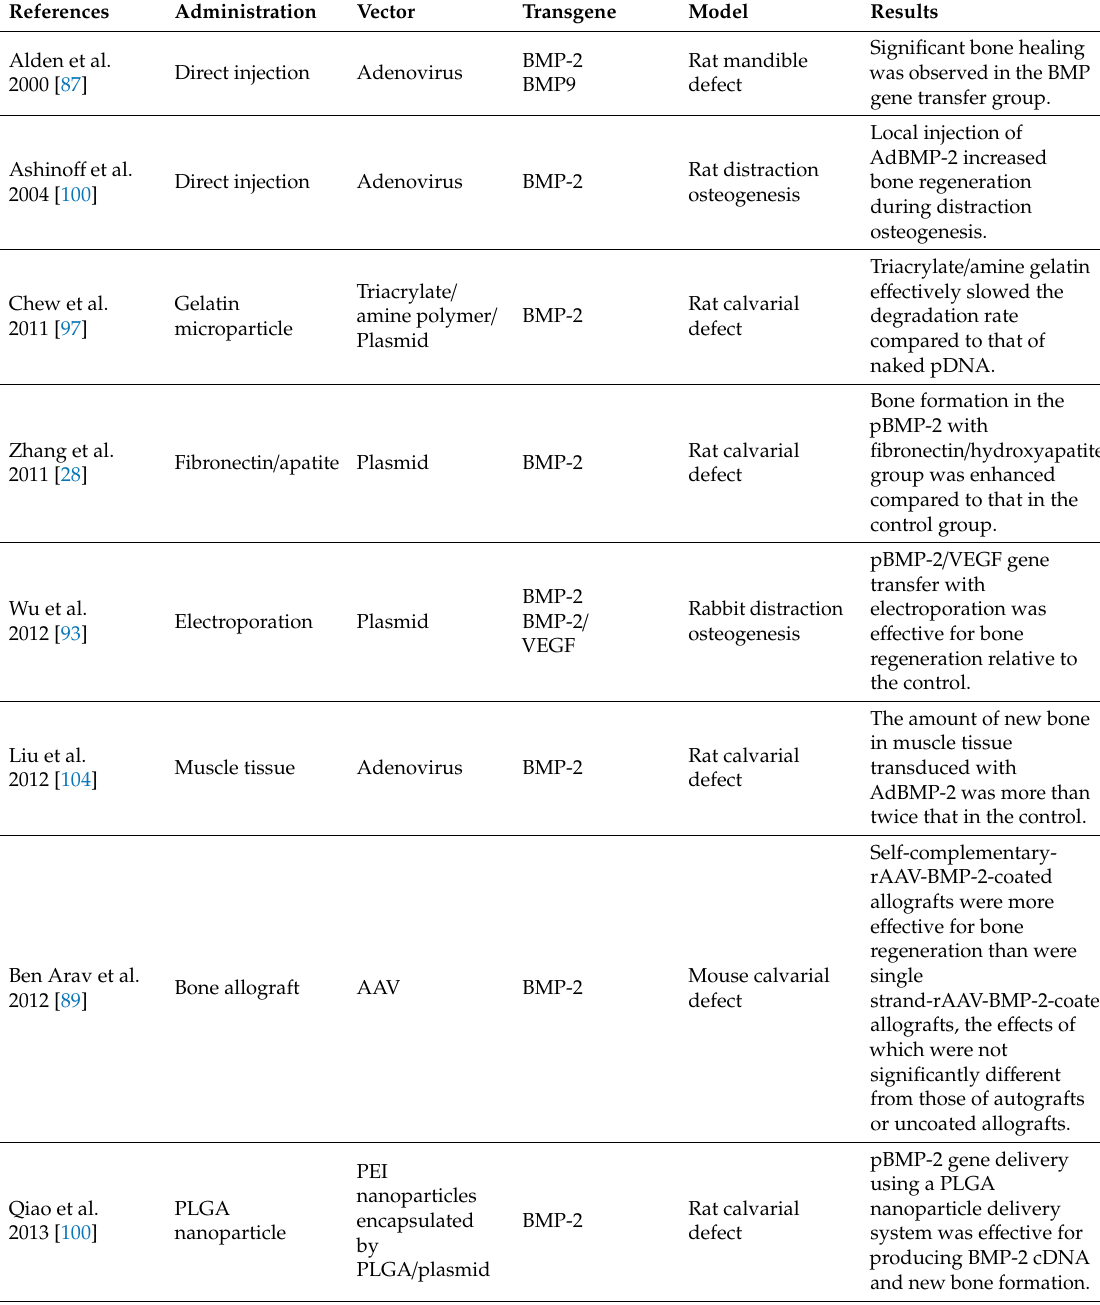
Table 4. In vivo BMP-2 gene therapy for bone regeneration in oral and facial